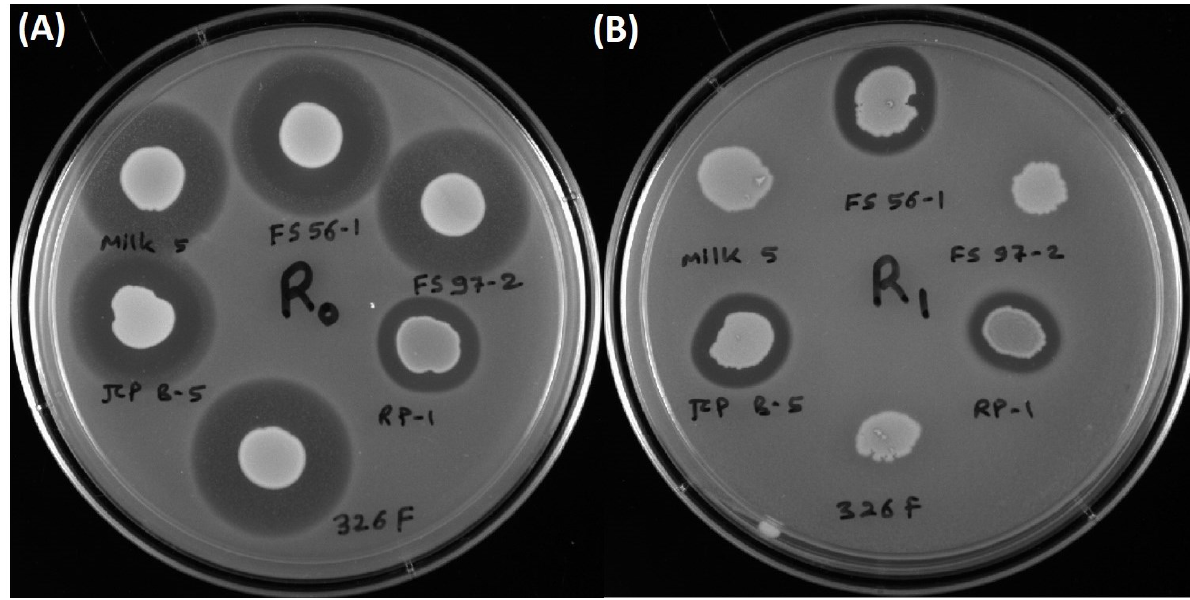
Figure 4. Culture spots of various Bac+ Enterococcus strains used in this study ( En. faecium FS56-1, FS97-2, 326F, JCP B-5, Milk5; En. thailandicus RP-1) applied onto fresh lawns of wild type Listeria monocytogenes R0 (39-2) and a curvaticin FS47 Bac R derivative of strain R0, L. monocytogenes R1 (39-2). Panel A, inhibition by all Bac+ culture spots against wild-type L. monocytogenes 39-2 R0 strain. Panel B, inhibition using the same cultures in panel A against the Bac R L. monocytogenes R1